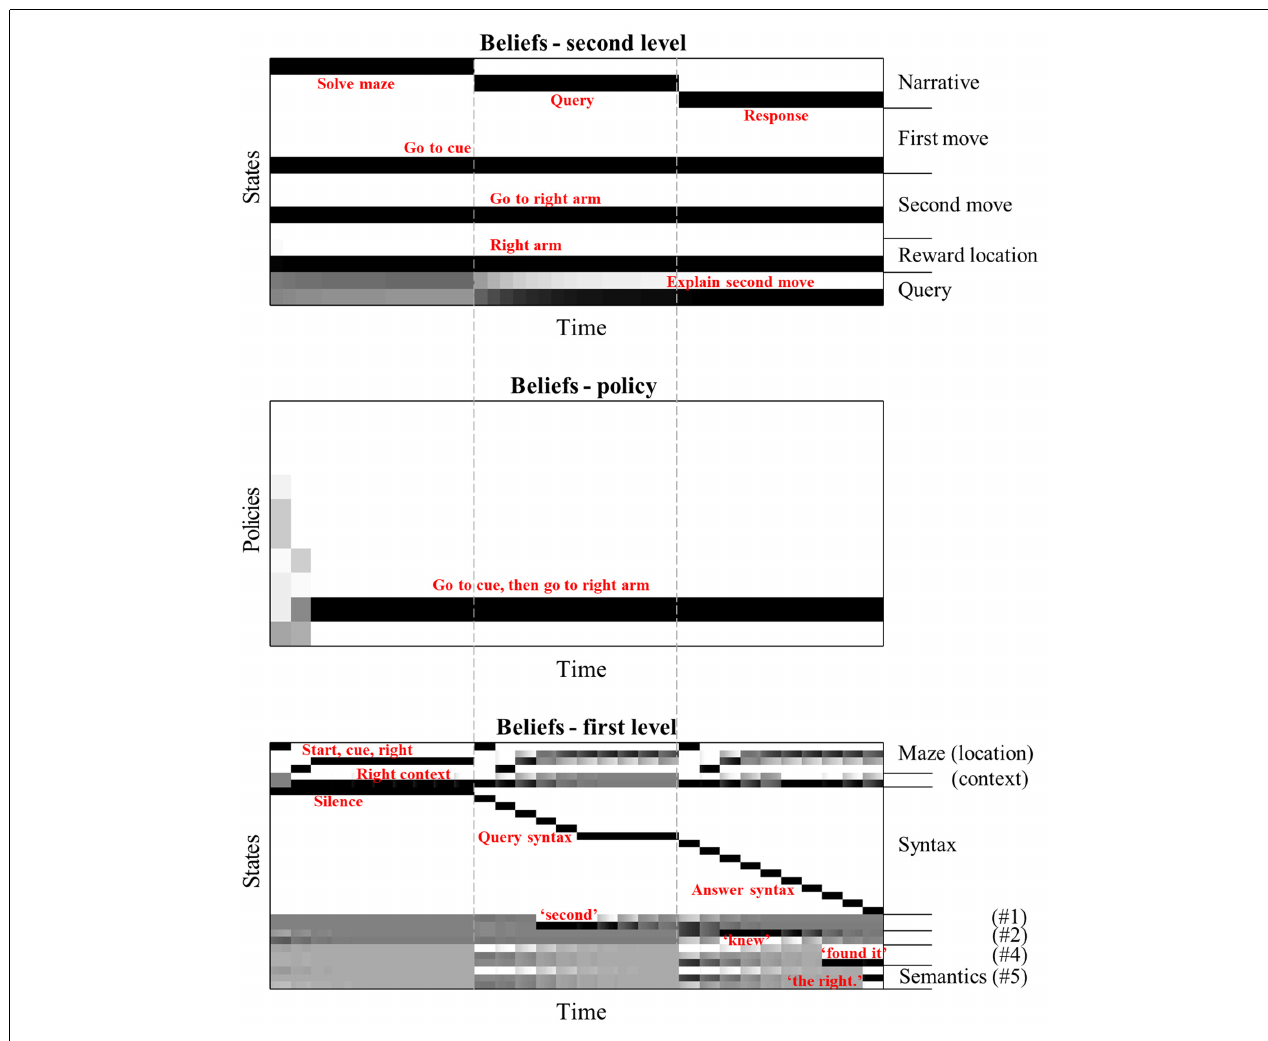
FIGURE 3 | Hierarchical belief updating . This figure shows the beliefs about states and policies over time in the temporally deep model. The main message of this figure is that this updating occurs over distinct timescales, with the first level states being updated much faster than those of the second level. The layout of these plots are as follows. Each row within each plot represents an alternative state or policy. The x -axis represents time; such that columns of the plot are discrete time steps. The shading of each cell in the state (or policy) x time arrays indicates the posterior probability assigned to that state (or policy) at that time. Black is a probability of one, white of zero, with intermediate shades representing intermediate probabilities. To avoid overcrowding, we have not labelled each row individually, but have annotated the states (and policies) that are inferred to be most likely in red. The vertical dashed lines indicate the alignment of the three epochs at the slowest (second level) with the inferences about the policies and states. Interpreted from a computational neuroscience point of view, each row of each plot can be regarded as a raster plot, indicating the aggregated firing rates of a distinct population of